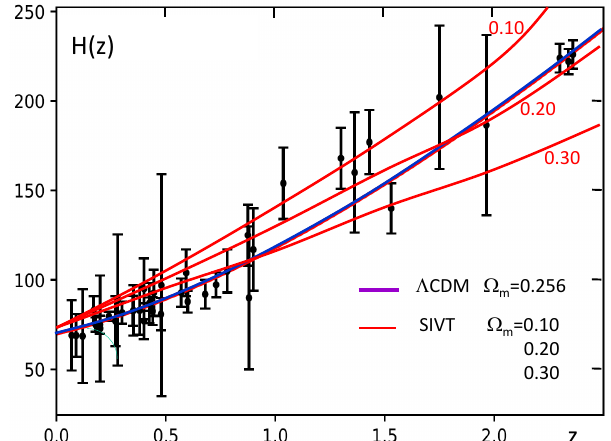
Figure 7. The observed expansion rates as a function of redshifts, compared to the flat Λ CDM Ω m = 0.256 as given by de Jesus et al. [21]. The scale invariant models with various values of also represented by red lines. For consistency within the SIV, and also because it is model independent, we take the value of H 0 based on the distance ladder: H 0 = 74 km s − 1 Mpc − 1 as in Figure 3, while de Jesus et al. [21] have H 0 = 69.5 ( ± 2.5 ) km s − 1 Mpc − 1